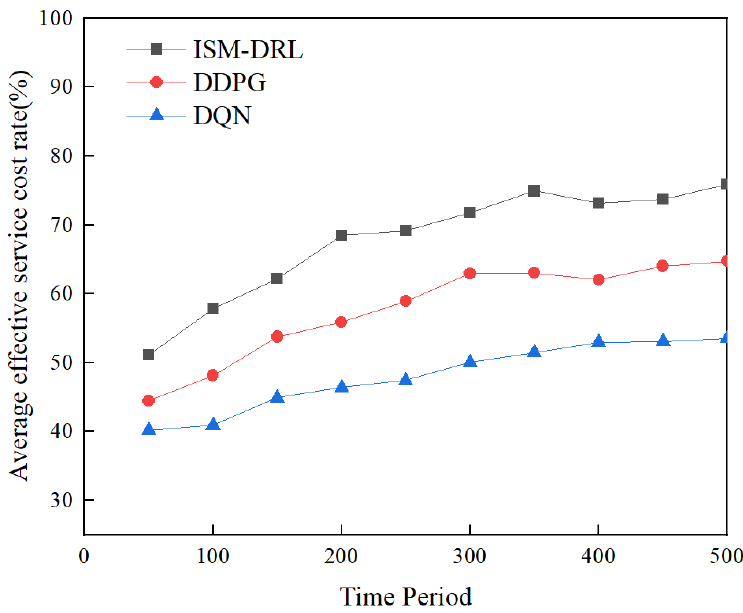
Figure 4. Average effective service cost rate at α 1 = 0.5, α 2 =